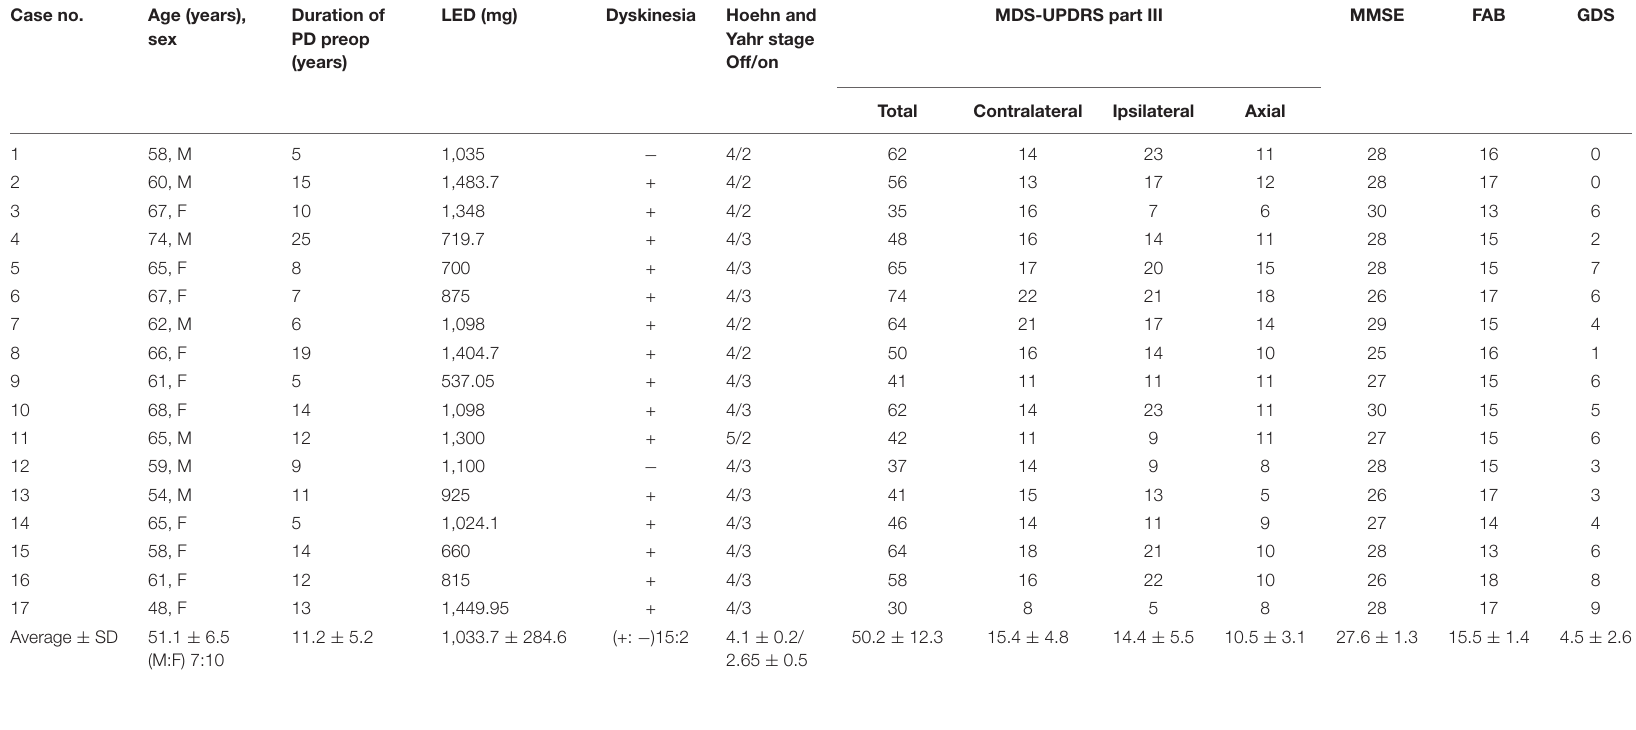
TABLE 3 | Baseline characteristics of 17 patients with advanced Parkinson’s disease received unilateral deep brain stimulation of the globus pallidus internus (GPi-DBS). Case